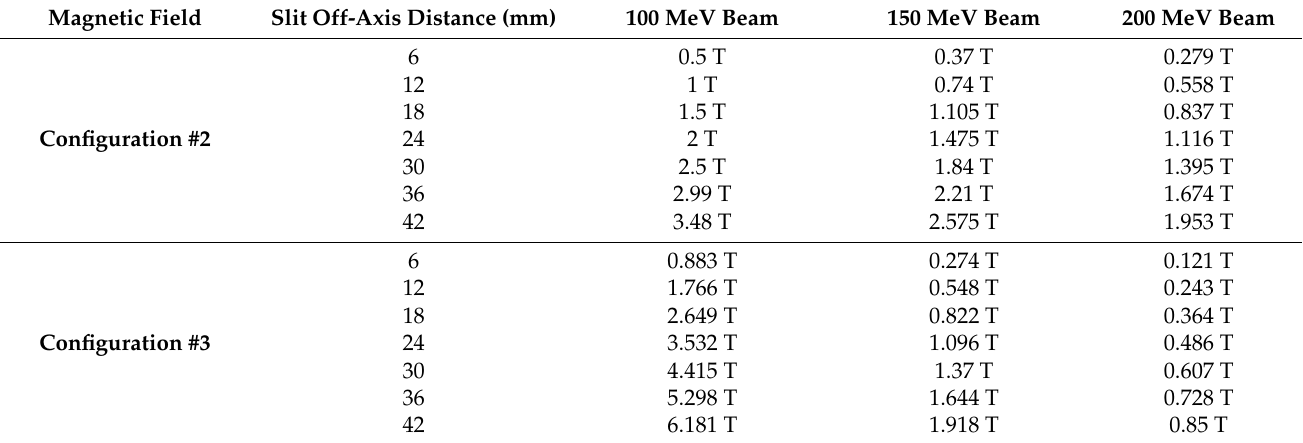
Table 1. Intensity of the magnetic field optimized for the two configurations as a function of the slit off-axis distance and the beam